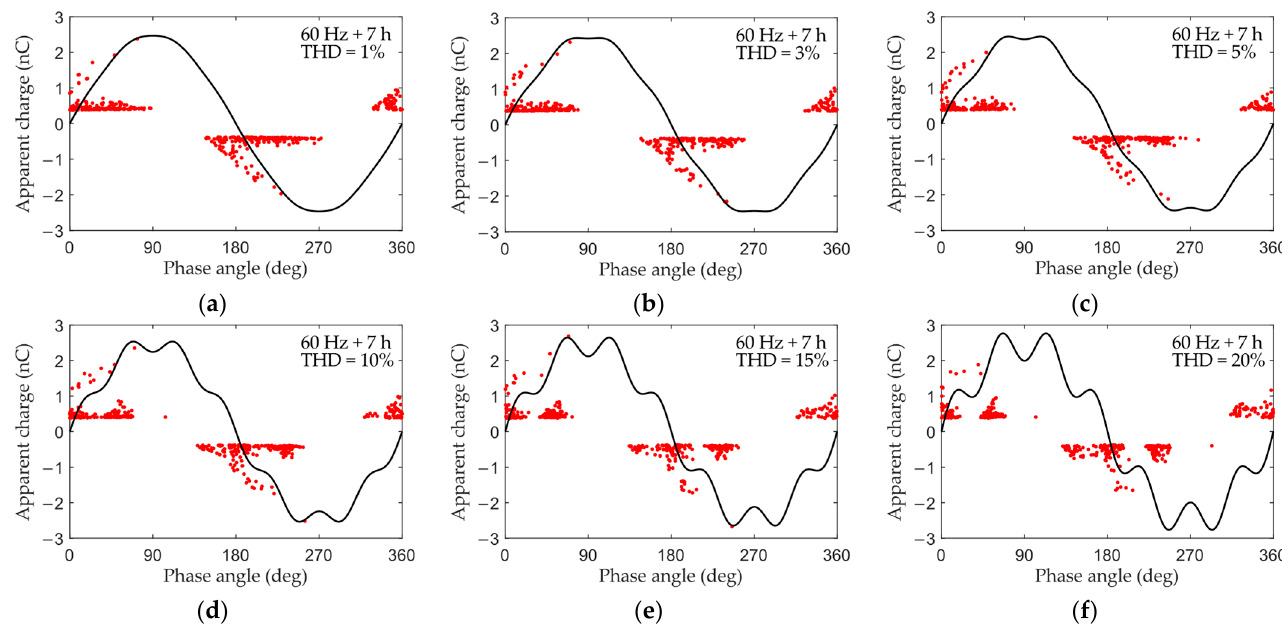
Figure 12. PRPD patterns obtained in the simulations for the cases wherein voltages distorted by the 7th harmonic component was applied with 𝜑 (cid:3035) = 0° and THD = : ( a ) 1%; ( b ) 3%; ( c ) 5%; ( d ) 10%; ( e ) 15%; ( f ) 20%. ( e ) 15%; ( f )